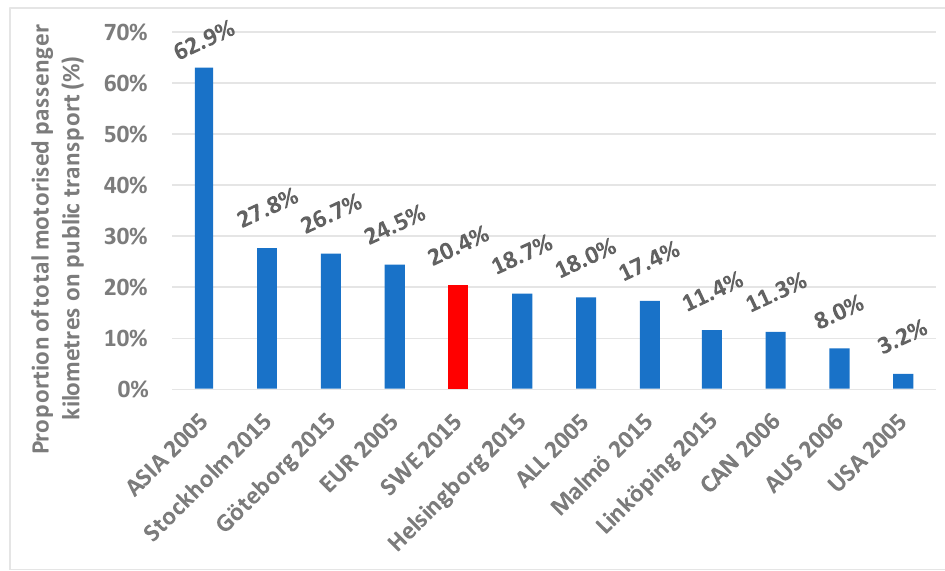
Figure 14. Proportion of total motorised passenger kilometres on public transport in five Swedish cities (2015) compared to a sample of global cities (2005–2006).